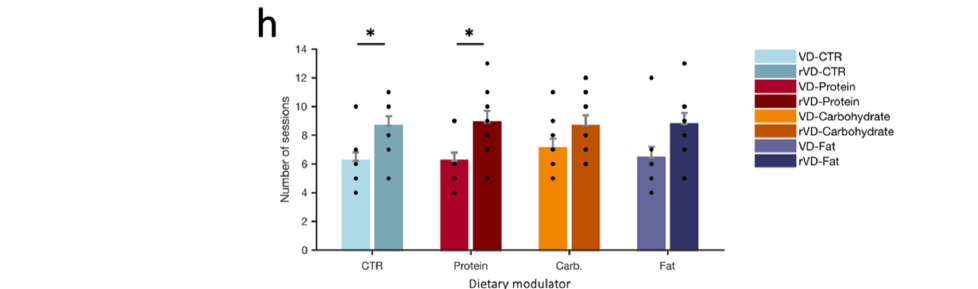
Figure 1. ( a ) Timeline of the visual discrimination (VD) and reverse VD (rVD) schedules during the learning phase (without dietary modulators) and under dietary modulators. ( b ) Schematic of the apparatus during the initial learning ‘Punish incorrect’ phase. ( c ) Schematic of the apparatus during the visual discrimination (VD) task (image pairs introduced). ( d ) Percentage of correct trials during the VD phase when all trials are considered under the different dietary modulators. ( e ) Number of sessions required to reach criterion for the VD phase under the different dietary modulators. Black dots indicate individual animals; animals with the same values overlap. ( f ) As in d, but for the reverse VD phase; asterisk refers to CTR vs. carbohydrate. ( g ) As in e, but for the reverse VD phase. ( h ) Numbers of sessions needed to reach criterion (>80% for 3 consecutive sessions) across dietary modulators in the VD and rVD phases. Values reported as mean ± SEM ( d , f ) or mean + SEM ( e , g , h ). N = 9 mice. p -values reported as follows: * p ≤ 0.05. Carb.: carbohydrate, CTR: control.